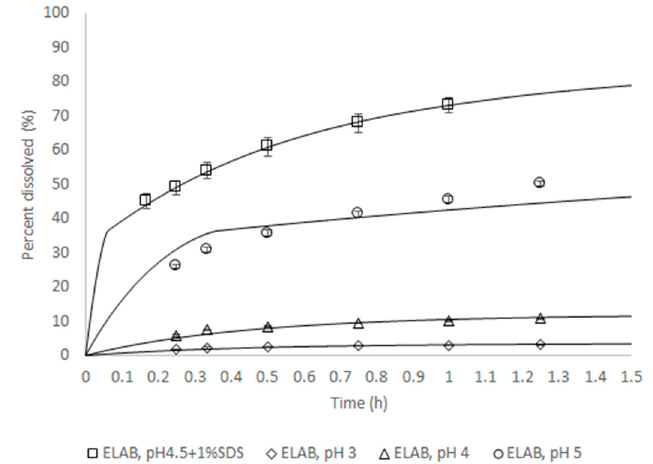
Figure 2. In vitro dissolution rate for batch ELAB fitted using the Quality Control (QC) method or predicted for all other conditions. The lines are predictions and symbols measurements.